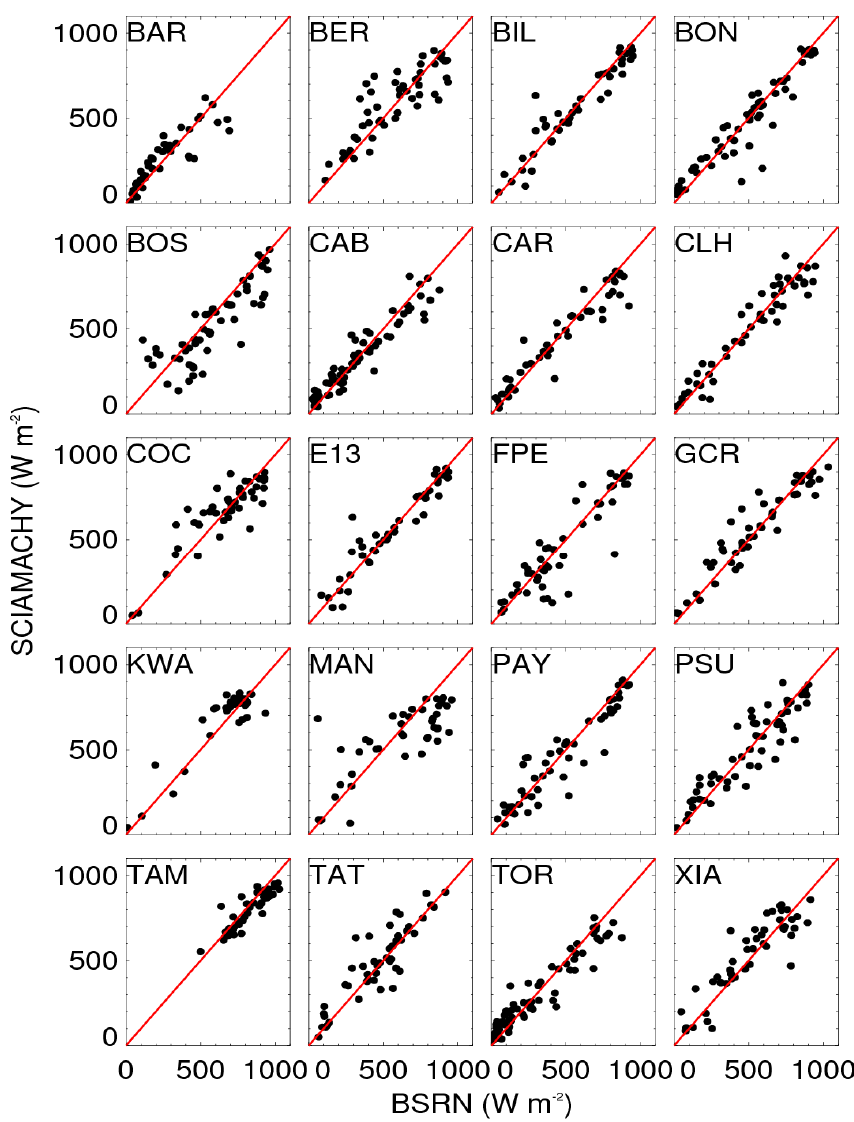
Fig. 6. Scatter plots of the instantaneous surface solar irradiances derived from SCIAMACHY versus the hourly mean BSRN global irradi- Figure 6. Scatter plots of the instantaneous surface solar irradiances derived from 2 ances for every station in 2008. Same data as in Fig. 5. The red lines indicate the one-to-one SCIAMACHY versus the hourly mean BSRN global irradiances for every station in 3 2008. Same data as in Fig. 5. The red lines indicate the one-to-one lines. 4